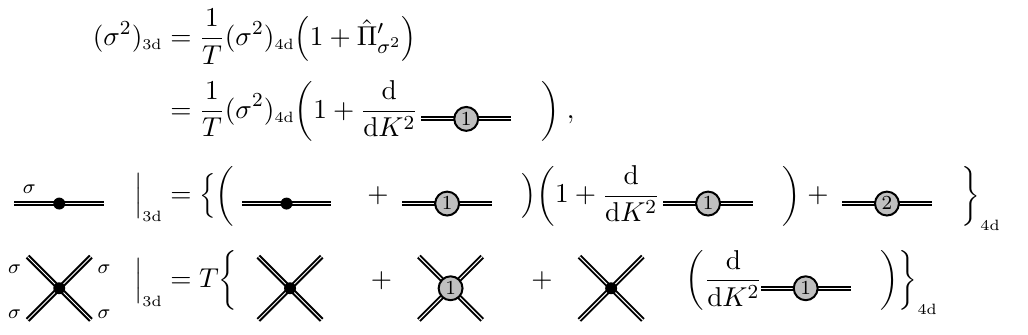
Figure 3 . Illustration of a ( g 4 ) NLO matching of correlators between 3d and 4d theories O with Z 2 -symmetry. A full non- Z 2 -symmetric case is analogous. Blobs present the sum of hard contributions to one- and two-loop diagrams in perturbation theory, and the differentiation (prime) acts upon the external soft momentum K = (0 , k ). The diagrams were drawn with Axodraw [233].